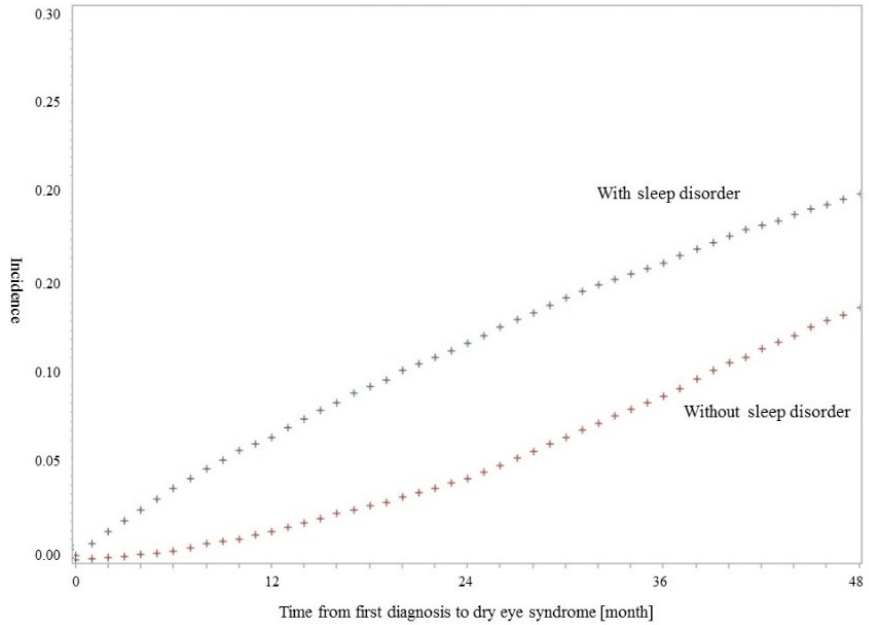
Figure 1. Kaplan-Meier survival curve for incidence of dry eye syndrome (DES). The results of log-rank test for time to DES by diagnosis of sleep disorders were statistically significant. Table 2. Results of survival analysis using Cox proportional hazard model for association between sleep disorders and dry eye